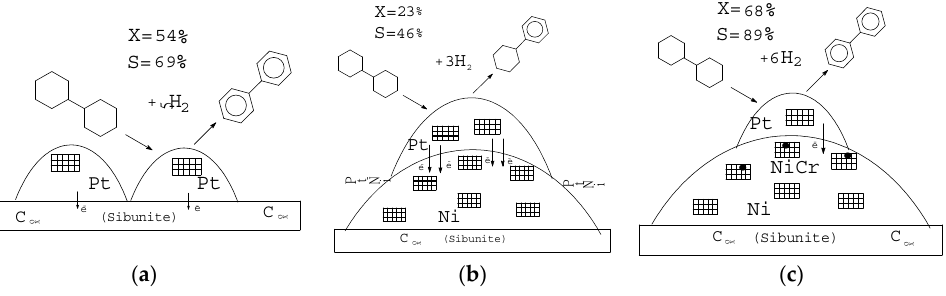
Figure 5. Scheme of bicyclohexyl dehydrogenation on catalysts 0.1Pt/C ox ( a ), 0.1Pt/3Ni/C ox ( b ) and 0.1Pt/1.5Cr/3Ni/C ox ( c ).